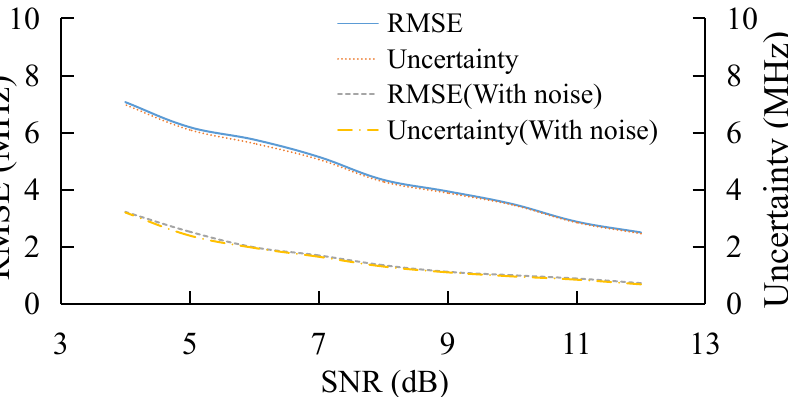
Figure 3. BFS extraction based on training samples with or without noise under different SNR.